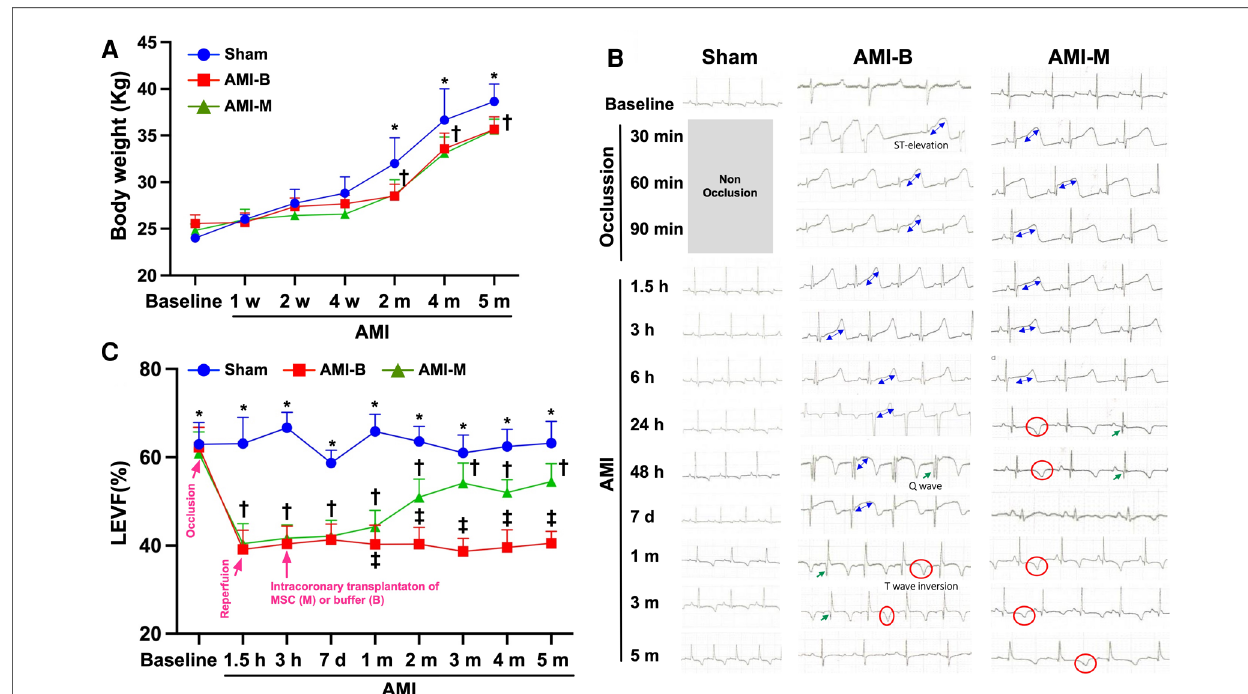
FIGURE 1 Serial changes of LVEF, ST-segment resolution, and the BW among the three groups of the animals. ( A ) The body weight at baseline to 4 weeks after AMI induction did not differ among the three groups, p >0.5. However, the body weight was notably increased in Sham than in AMI-B and AMI-M groups, * vs. † , p <0.01. ( B ) Illustrating the serial ECG examinations and the results showed that after 8 h AMI induction, the ST-segment resolution was remarkably greater in AMI-M (i.e., group 3) than in AMI-B (i.e., group 2). ( C ) By 1.5 h and 3 h as well as 7 h after AMI induction, the LVEF was signi fi cantly lower in groups 2 and 3 than group 1 (Sham), * vs. † , p <0.0001. Additionally, 1, 2, 3, 4, and 5 months after AMI induction, LVEF was still signi fi cantly lower in groups 2 and 3 than that in group 1, * vs. other groups with different symbols ( † , ‡ ), p <0.0001. All statistical analyses were performed by one-way ANOVA, followed by Bonferroni multiple comparison post-hoc test . Sham (group 1), sham-operated control; AMI-B (group 2), AMI+buffer; AMI-M (group 3), AMI+hBMMSC; AMI, acute myocardial infarction; hBMMSCs, human bone marrow-derived mesenchymal stem cells; LVEF, left ventricular ejection fraction; BW, body weight; ECG,